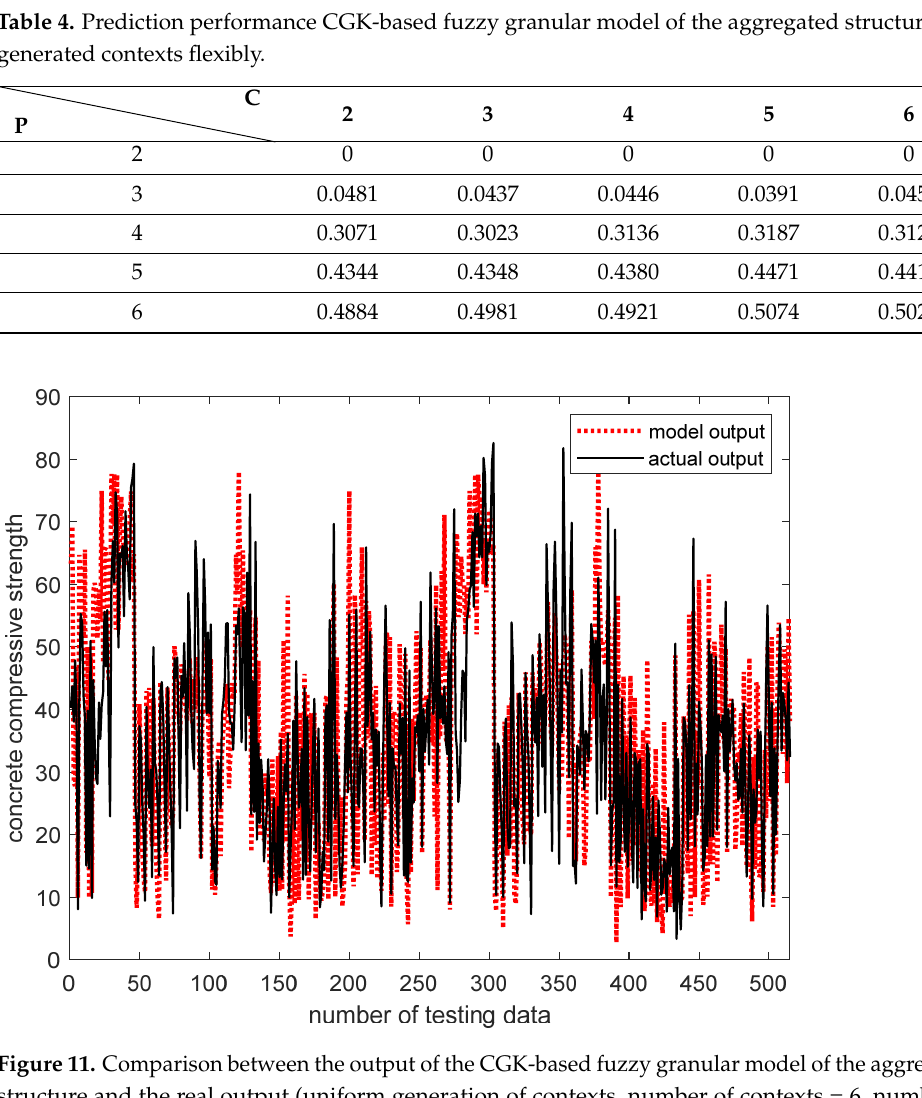
Figure 12. Performance index of the CGK-based fuzzy granular model of the aggregated structure for testing data (uniform generation of contexts, number of contexts = 6, number of clusters = 4). Table 5 summarizes the prediction performance of the optimized CGK-based fuzzy granular model that generated contexts uniformly. Table 6 summarizes the prediction performance of the optimized CGK-based fuzzy granular model of the aggregated struc- ture that generated contexts uniformly. Table 7 shows how the contexts in the output